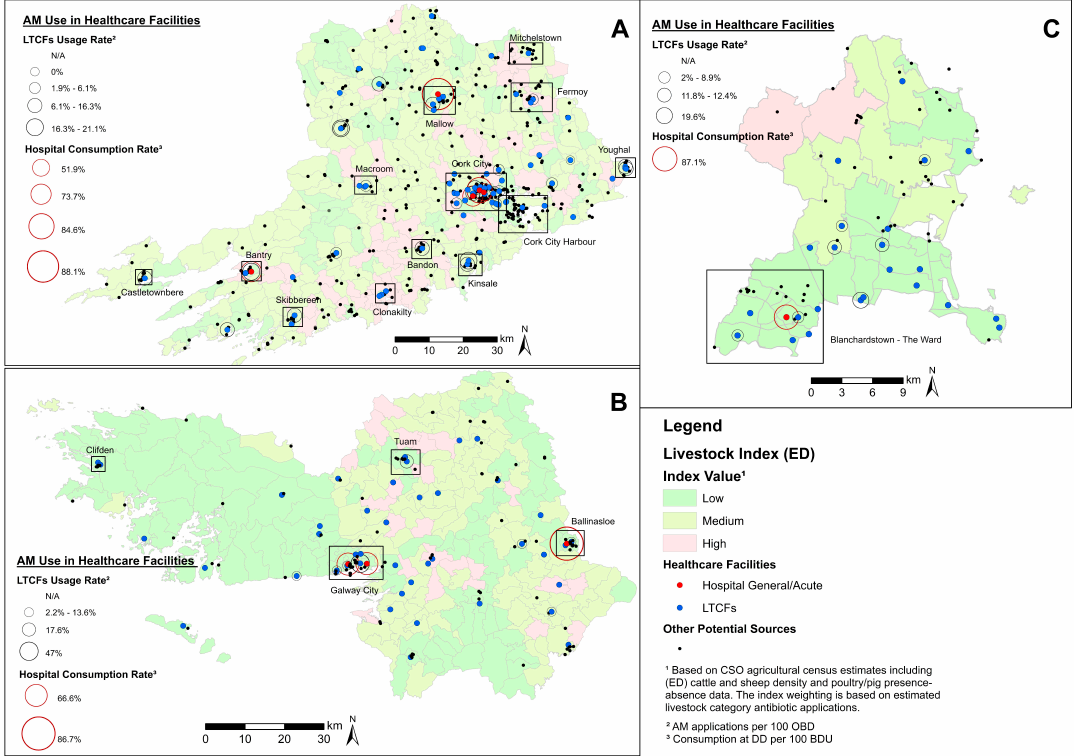
Figure 1. Composite map of potential antimicrobial resistant organisms (ARO) sources (unclassified) and healthcare facilities (including antimicrobial (AM) use) in County Cork, County Galway, and Fingal County. Notes: Livestock index estimates are included as a base map layer. Clusters of ARO sources in urban areas are delineated. LTCFs = long-term care facilities. ED = electoral district. CSO = Central Statistics